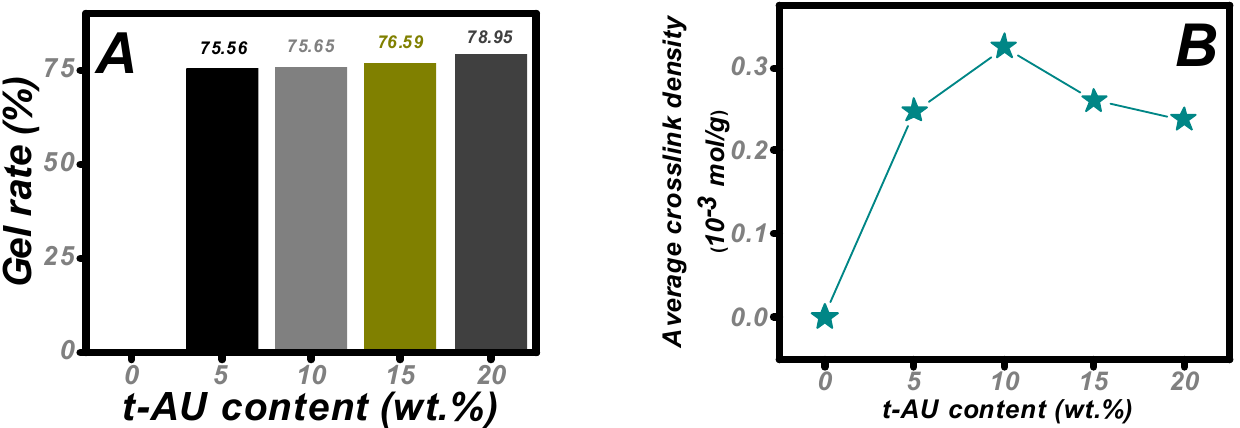
Figure 4. Gel rate ( A ) and average crosslink density ( B ) of AUP series based on a function of t-AU content.